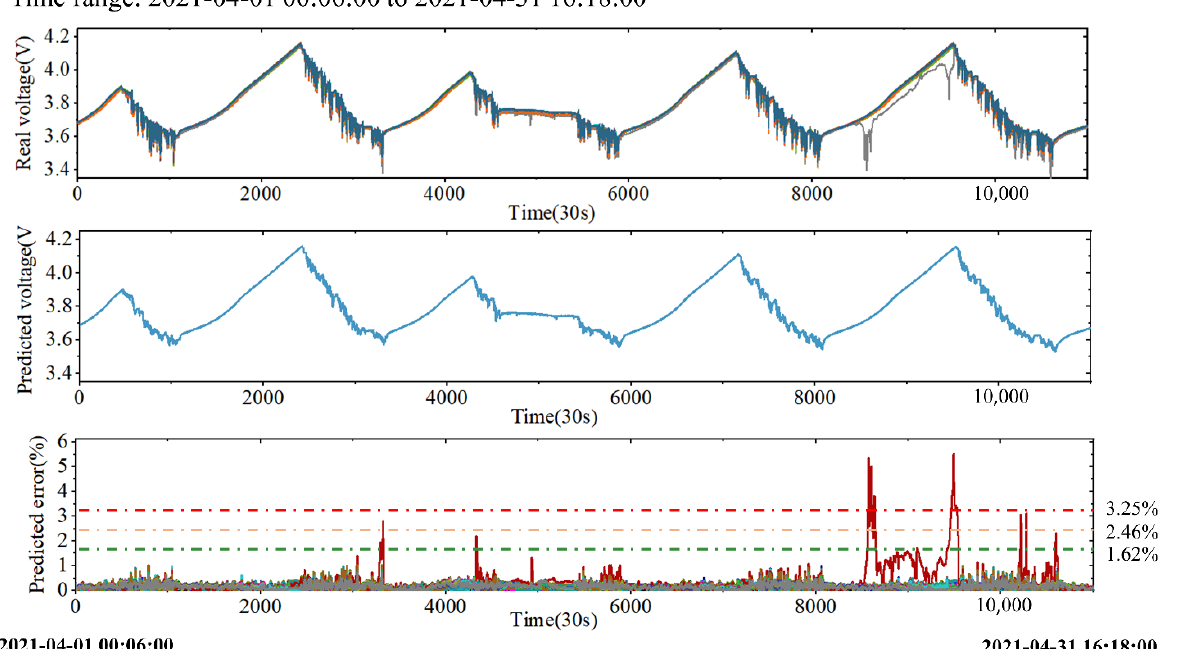
Figure 9. Battery voltage prediction results for no. 5 vehicle before TR.